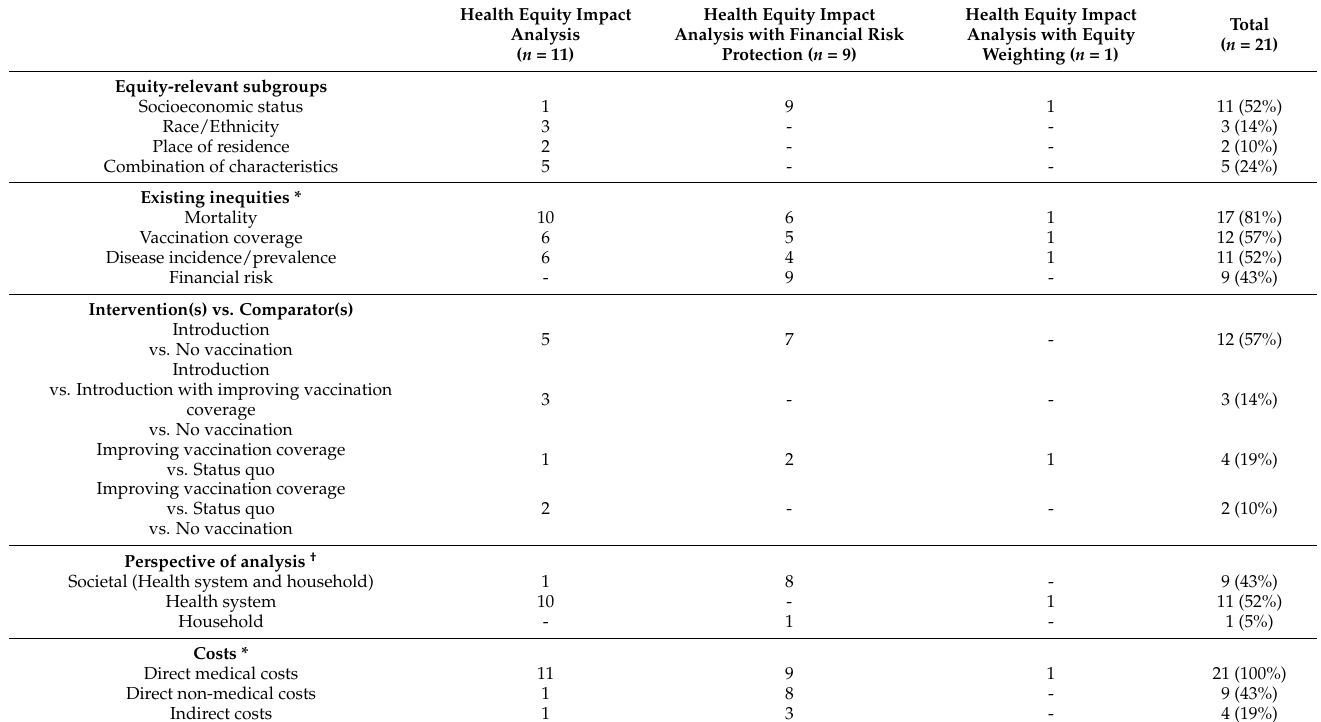
Table 2. Methodological characteristics of included